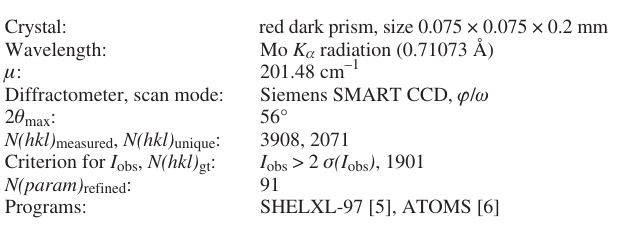
Table 1. Data collection and handling.